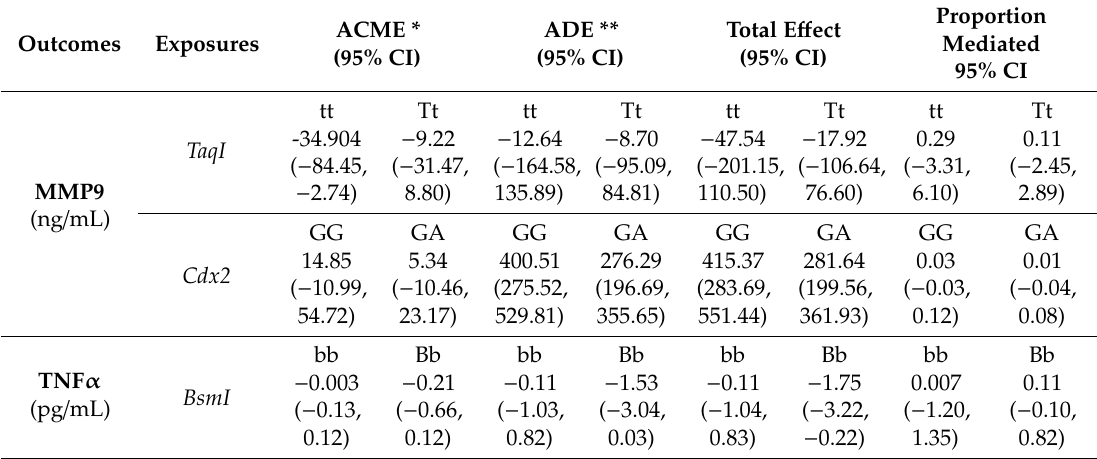
Table 6. Causal mediation analysis of the association between VDR SNPs and inflammatory biomarkers by inclusion of on-study plasma 25-hydroxy vitamin D (25(OH)D changes as mediator.